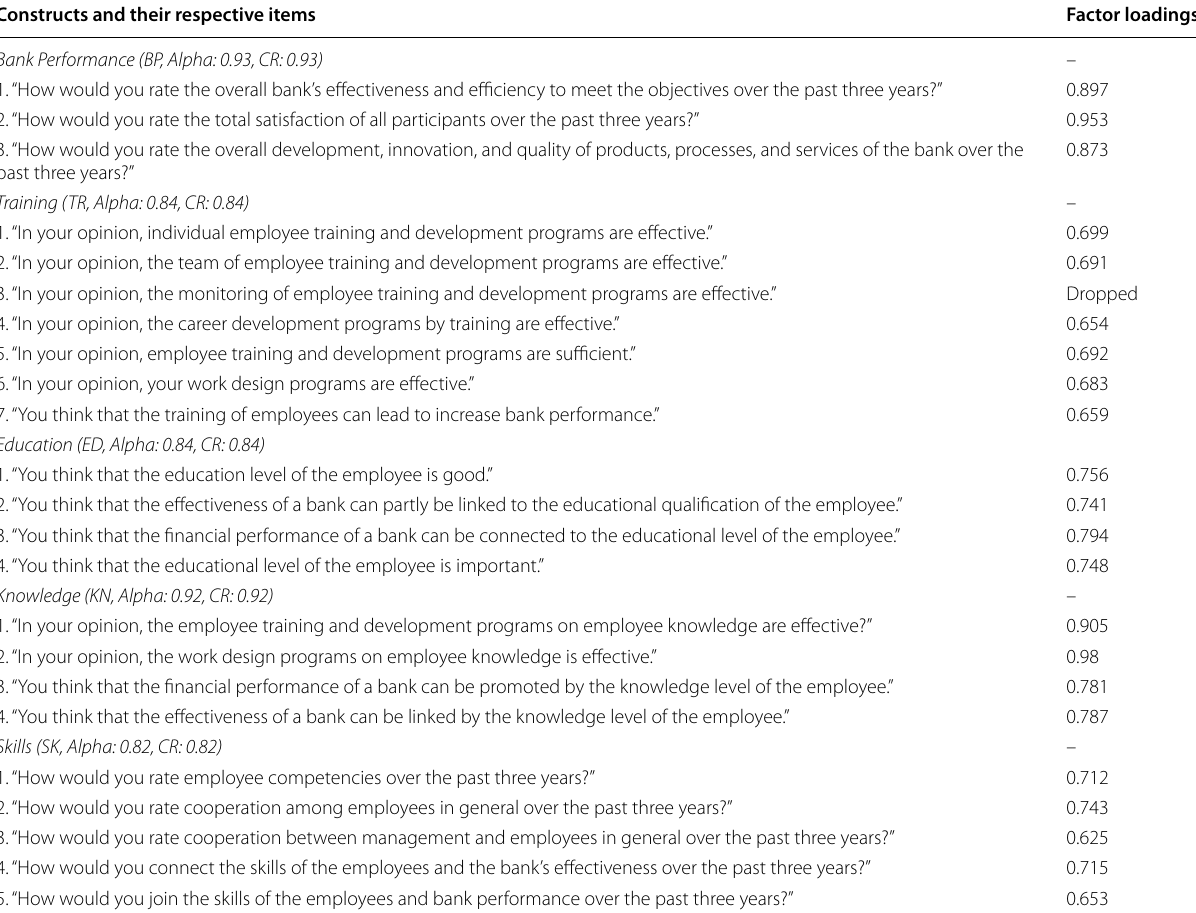
Table 2 Measurement items and their